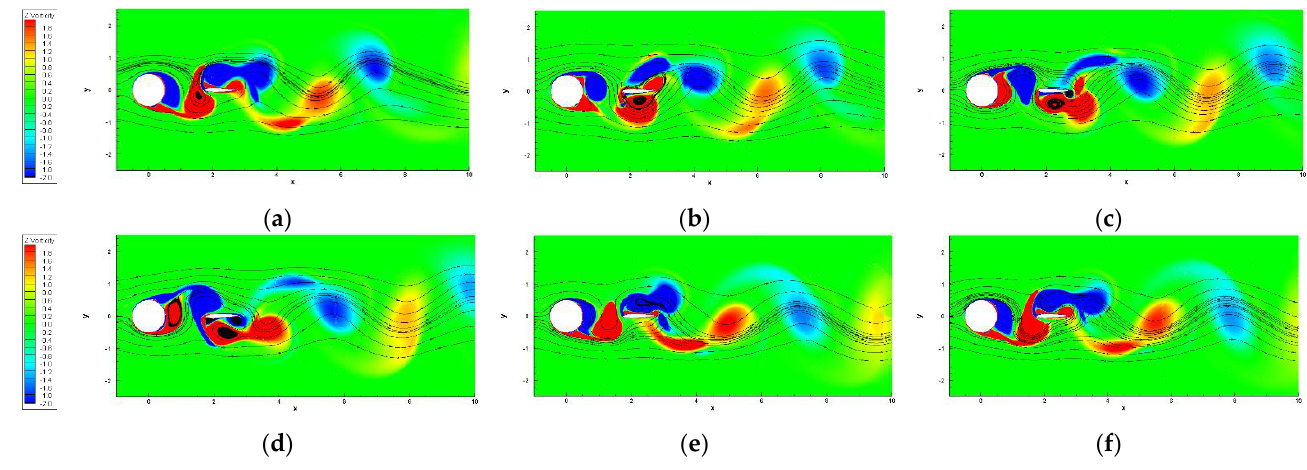
Figure 12. The flow mechanism ( x / D = 1.75, T / T 0 = 0.5): ( a ) t 0 ; ( b ) t 1 ; ( c ) t 2 ; ( d ) t 3 ; ( e ) t 4 ; ( f ) t 5 .